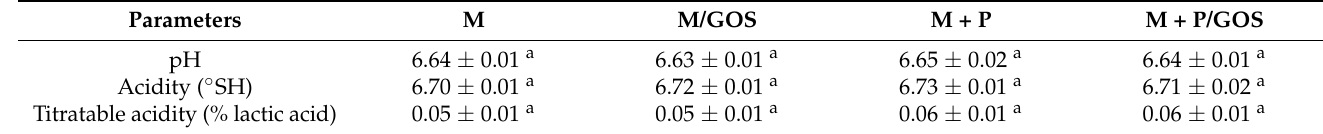
Table 2. Acidity of goat’s milk and goat’s milk with permeate after enzymatic conversion of